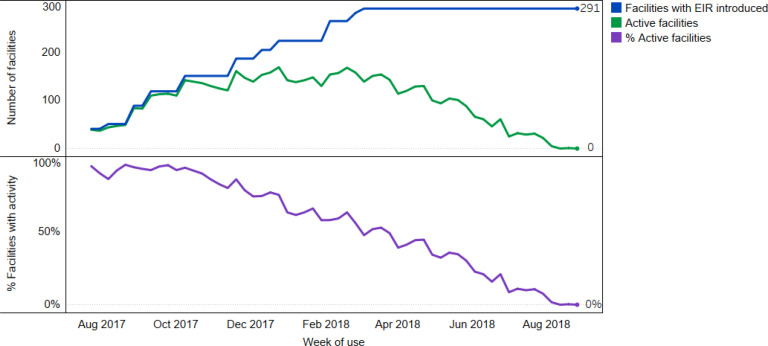
Number of Facilities in Southern Province, Zambia Using the EIR (top) and Percentage of Facilities Using the EIR (bottom)Abbreviation: EIR, electronic immunization registry.